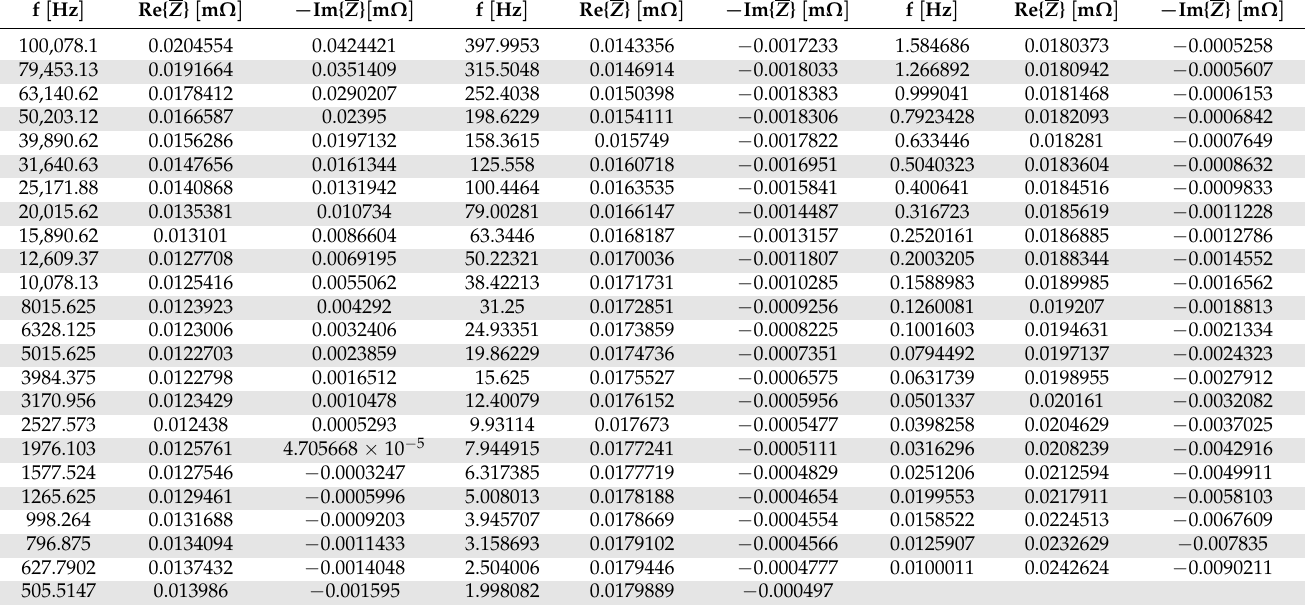
Table A11. EIS data for Murata Sony VTC6 at an SOC of